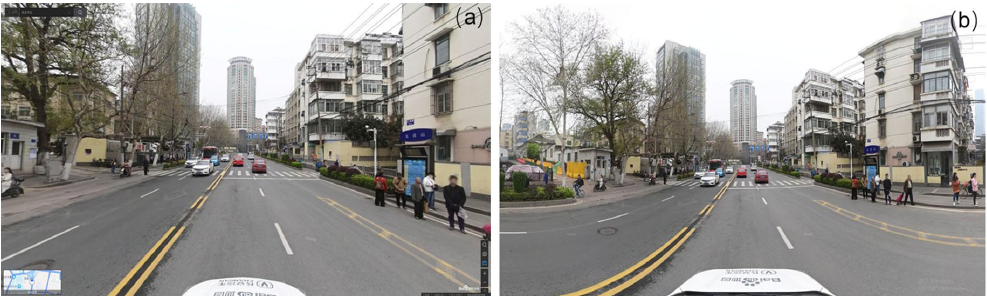
Figure 3. ( a , b ) A sample of collected street view image.